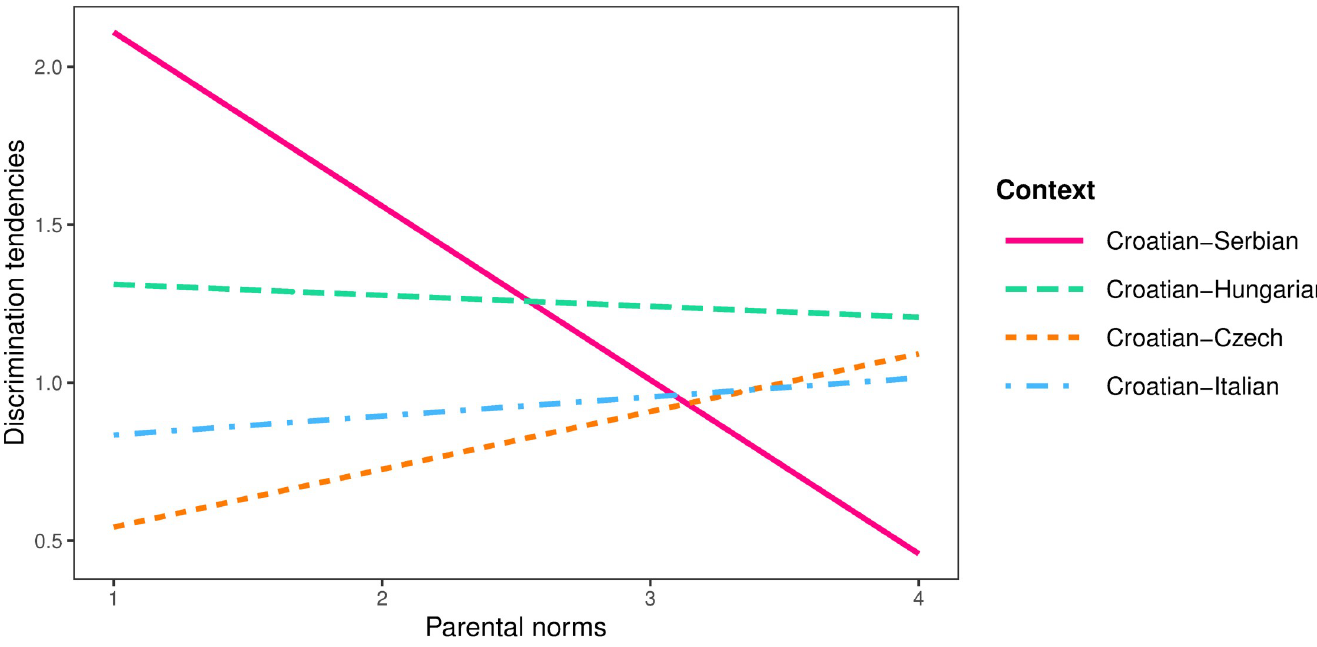
Fig 7. Interaction plot between parental norms and intergroup context on discrimination